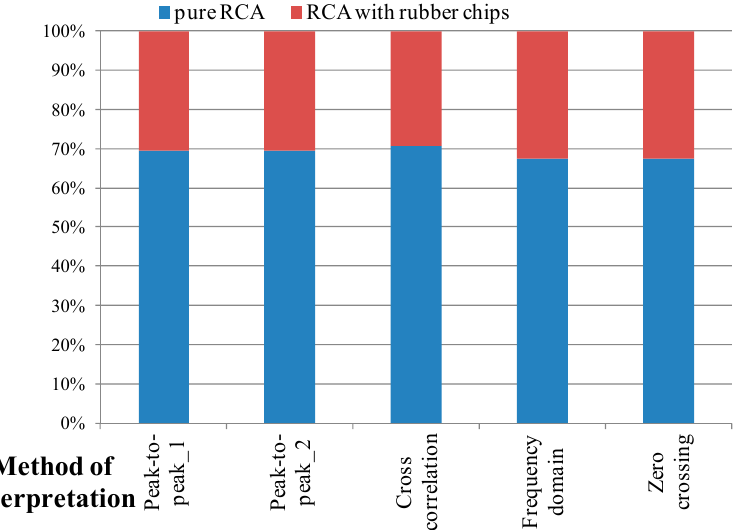
Figure 14. Percentage distribution of V S values between two different materials: pure RCA and RCA with rubber chips for p ′ = 90 kPa.